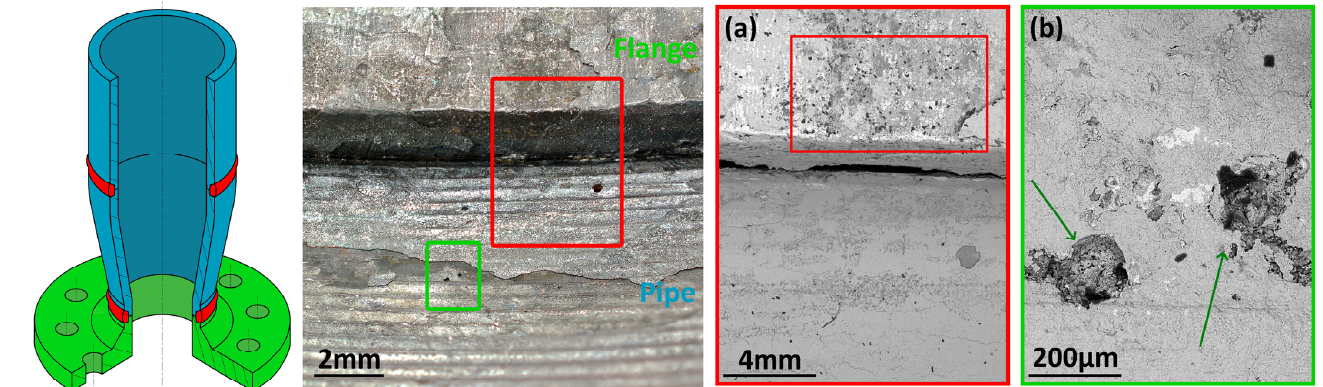
Figure 5. SEM investigation of the region characterized by the step between the two welded edges. Picture ( a ) shows lack of fusion and crevice. Picture ( b ) shows some of the observed corrosion pits.